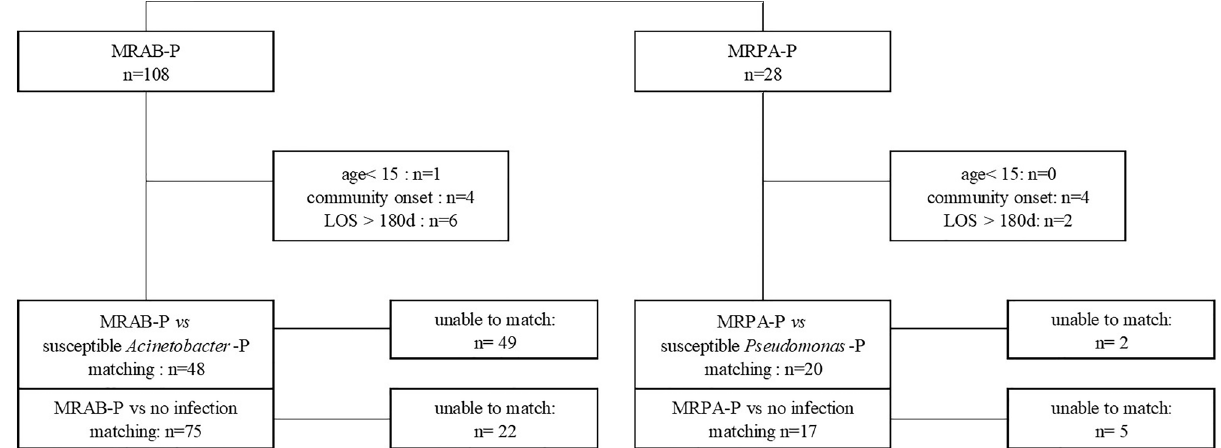
Figure 1. Flowchart of matching process for susceptible-organism pneumonia or no infection according to each type of pneumonia. MRAB-P multidrug-resistant A. baumannii pneumonia, MRPA-P multidrug- resistant P. aeruginosa pneumonia, LOS length of hospitalization, A. baumannii -P A. baumannii pneumonia, P aeruginosa -P P. aeruginosa